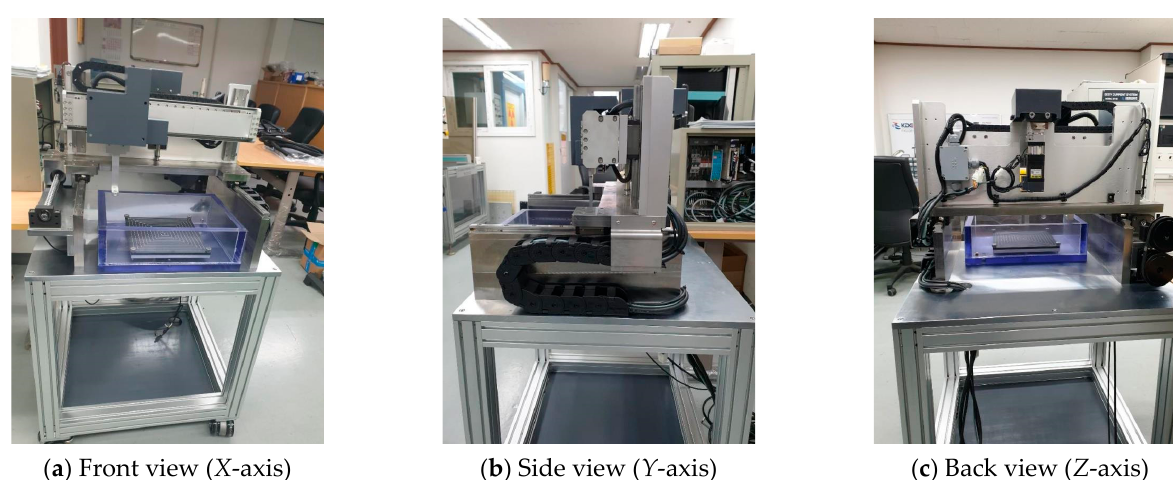
Figure 3. Design drawings of the fabricated 3-axis transport mechanism and frame (3D).